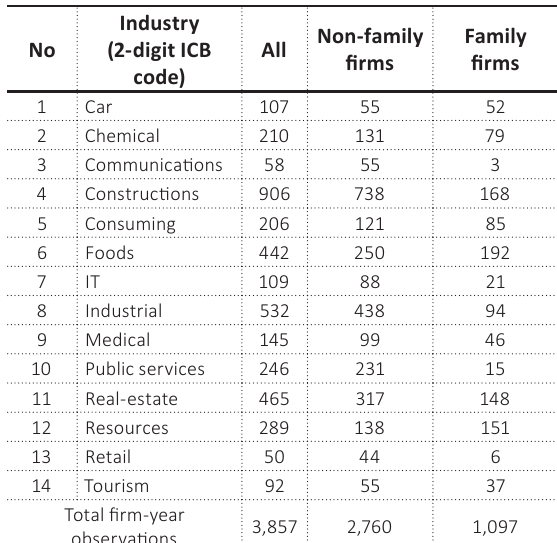
Table 1. Firms categorized by 2-digit ICB code